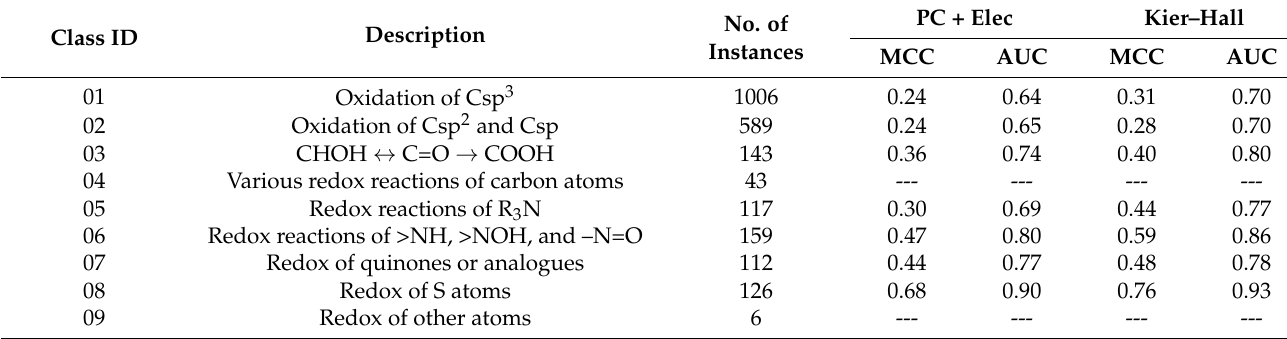
Table 3. Performance of the predictive models for the 21 classes of metabolic reactions based on US balanced datasets and exploiting two sets of descriptors (physicochemical plus stereo-electronic descriptors and Kier–Hall topological indices). Classes 09, 13 and 28 do not include enough instances (<50) to develop predictive models. Only overall performance metrics are